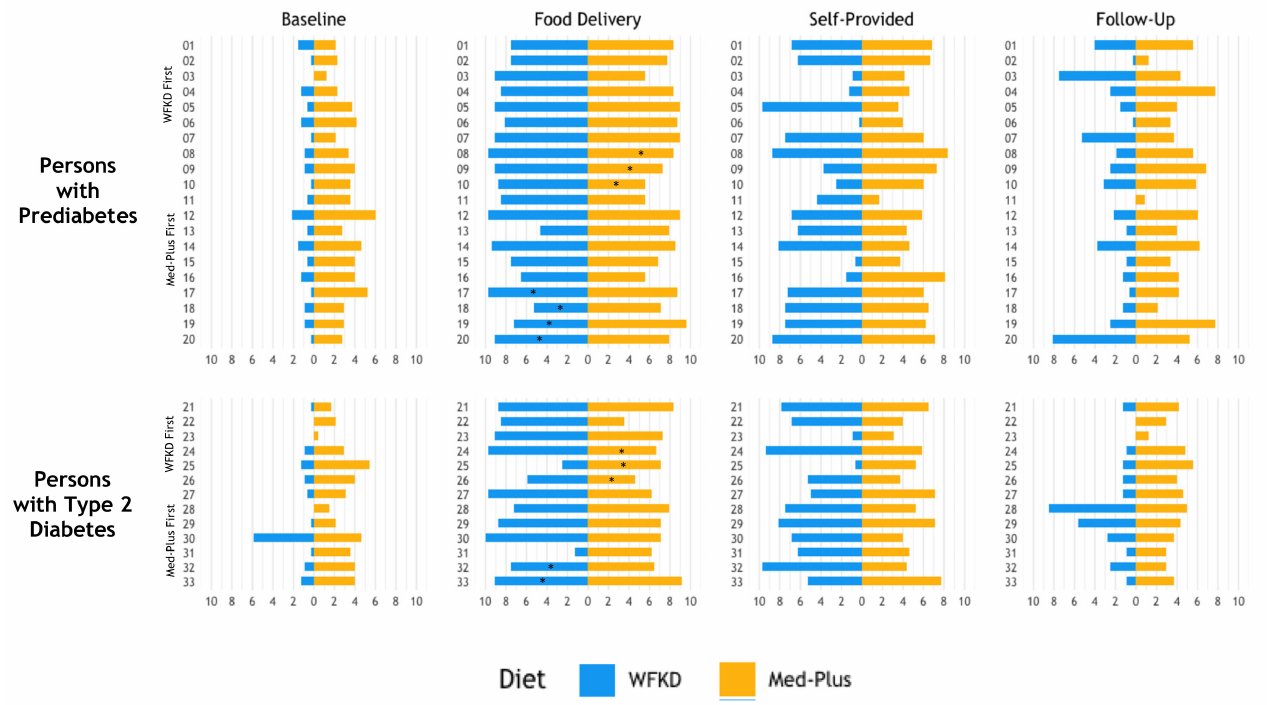
Figure 3. Comparisons of individual adherence during each phase of the study (baseline, food delivery, self-provided and Table 2 diabetes mellitus (T2DM). Data are shown for participants with data at all four time points. Due to disruptions in the study protocol caused by COVID-19, participants who did not receive food deliveries during their second diet phase are denoted with an asterisk